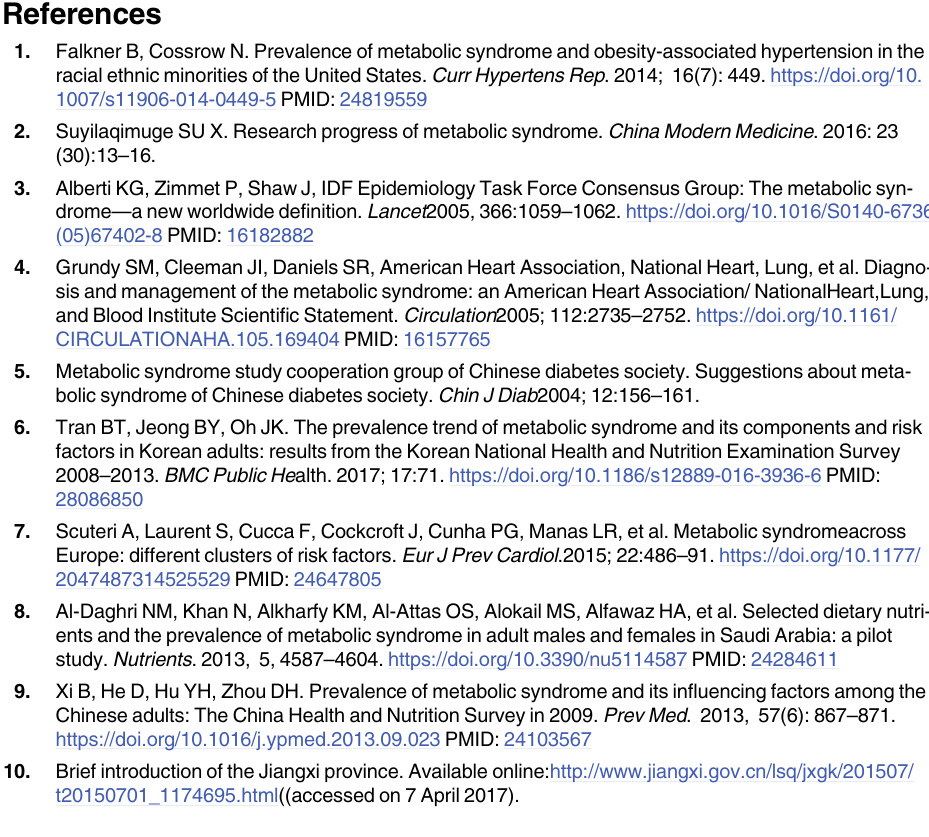
S8 Table. Questionnaire1 (original language). S9 Table. Questionnaire 2